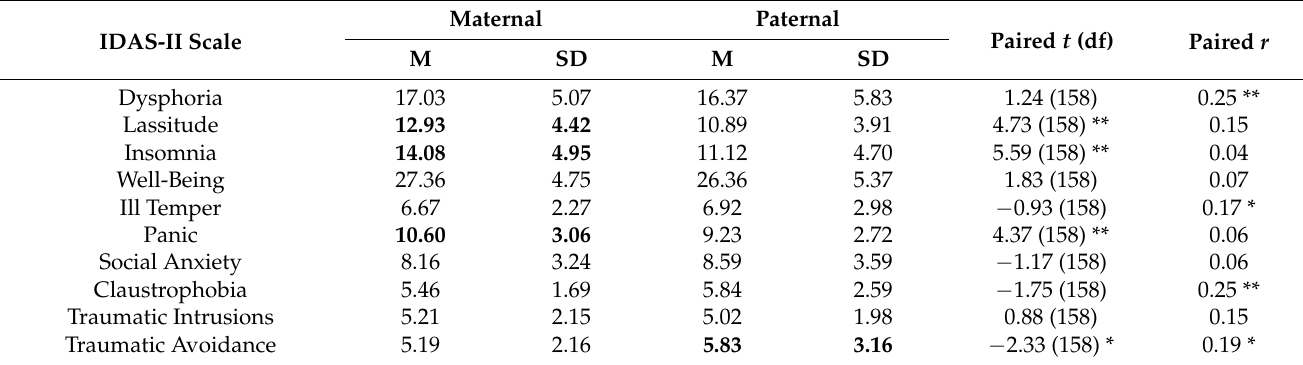
Table 1. Descriptive Statistics for IDAS-II Scales for Mothers and Fathers during